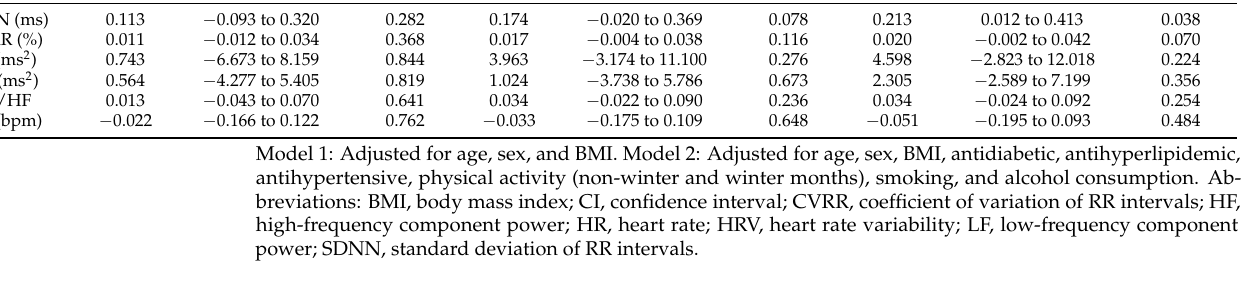
Table 4. Analysis of the association between HRV parameters and the Shannon